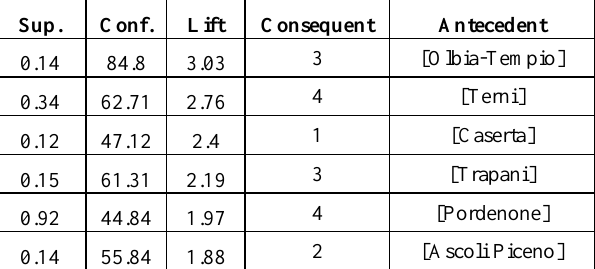
dependency of regions’ activity-level on seasons